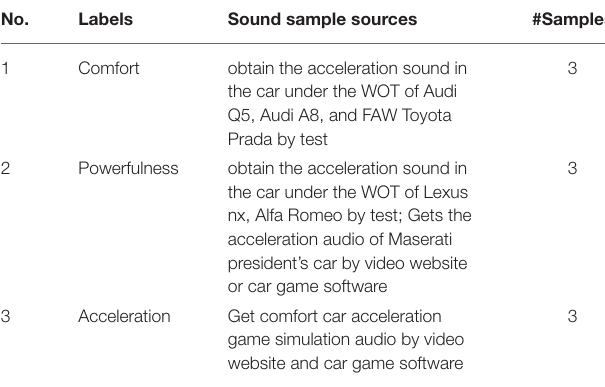
TABLE 1 | Details of the sound clips used in the EEG experiment.